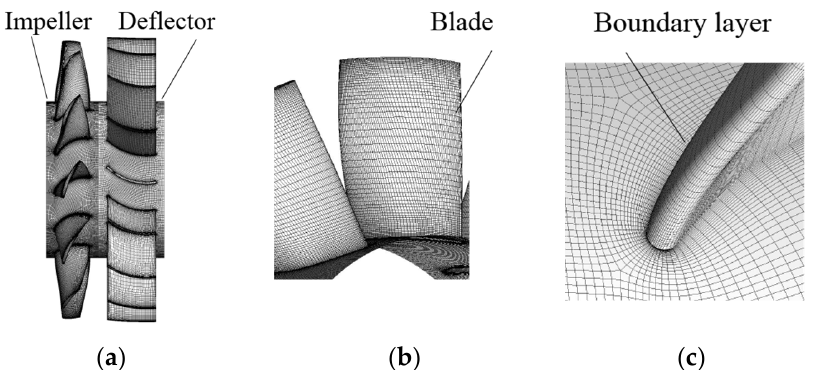
Figure 4. Mesh model of the axial flow fan: ( a ) the impeller and deflector; ( b ) the blade; ( c ) Boundary layer.